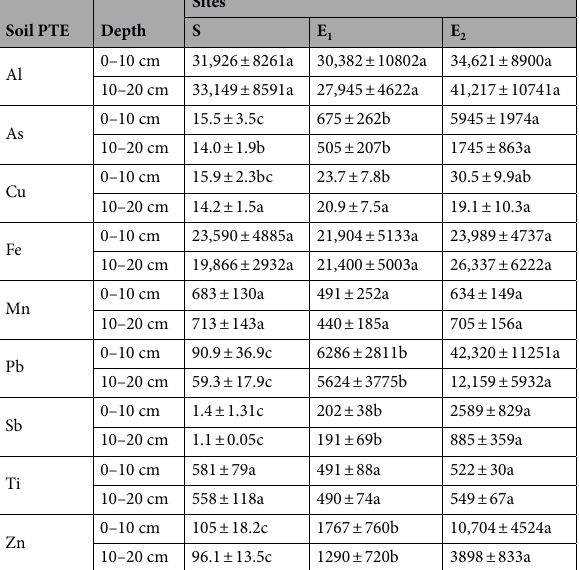
Table 2. Soil elements (PTE and other element pseudo-total concentrations in mg/kg) measured at 0–10 cm and 10–20 cm depth. In the same row, values (mean ± standard deviation (n = 5)) followed by different letters are significantly different (Wilcoxon test. P ≤ 0.05). Sites: S = reference site at Sormiou. E 1 = Escalette 1 and E 2 = Escalette